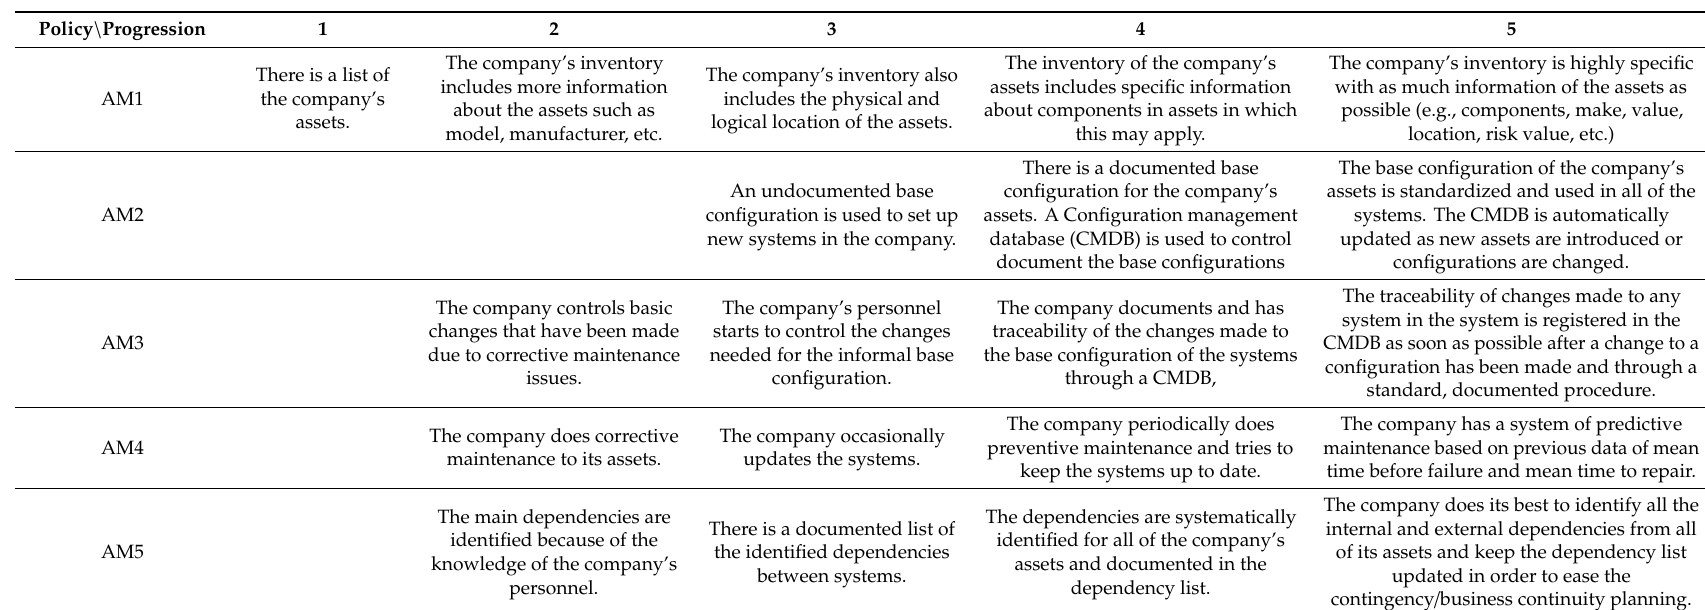
Table 10. Asset management policies’ progression